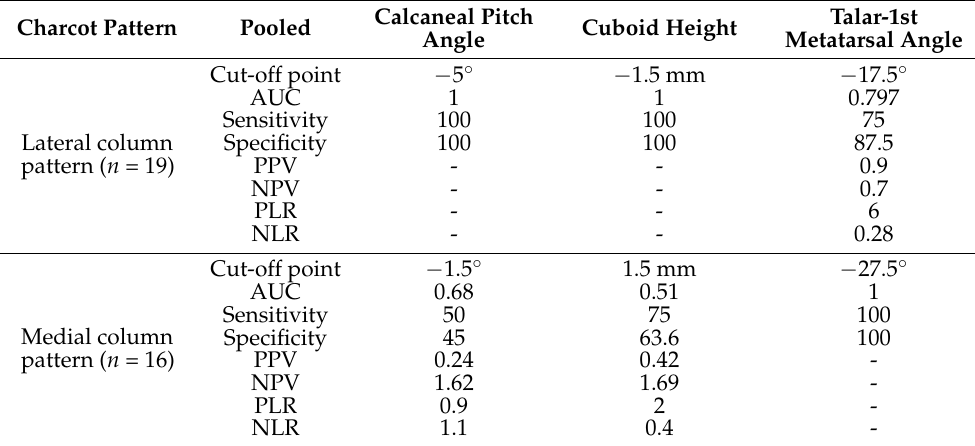
Table 3. Performance characteristics of radiographic measurements for lateral and medial Charcot midfoot